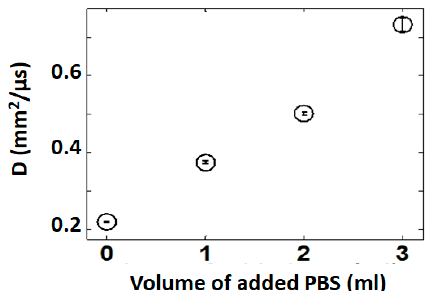
Figure 7. D increases when PBS is instilled into the lung, simulating edema ex-vivo. Three readings were taken for each measurement. The variability is demonstrated by the error bars. mean D ± SEM.